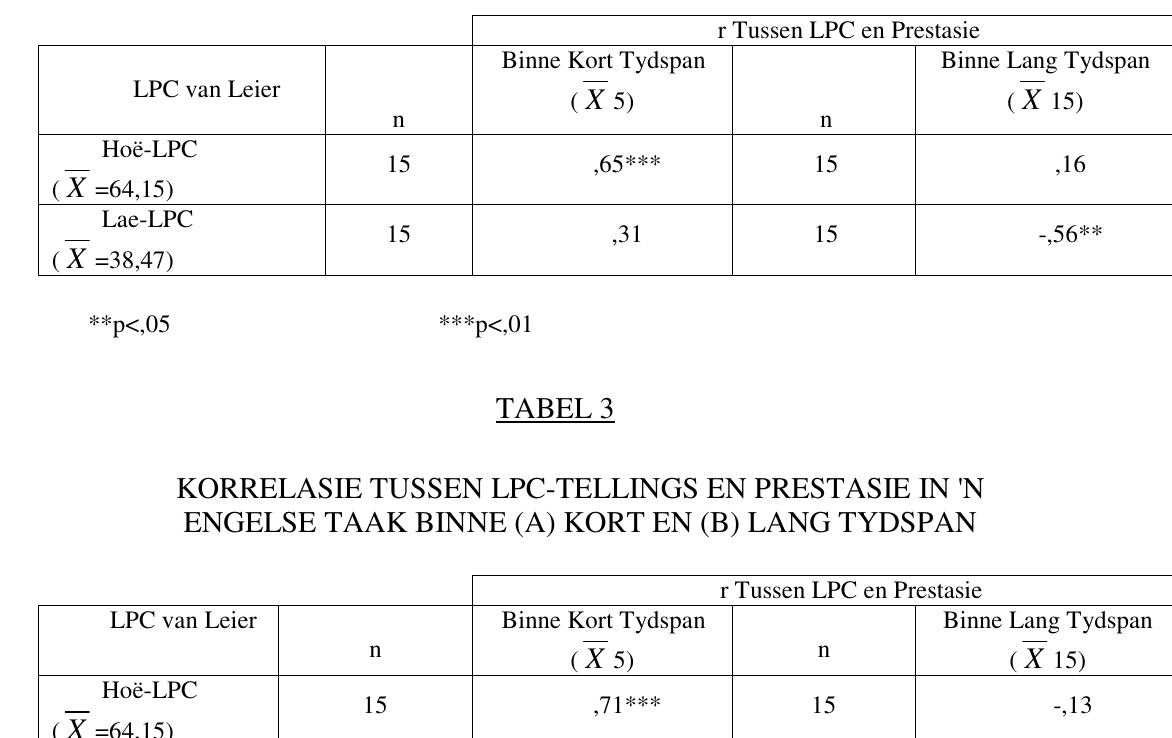
KORRELASIE TUSSEN LPC-TELLINGS EN PRESTASIE IN 'N